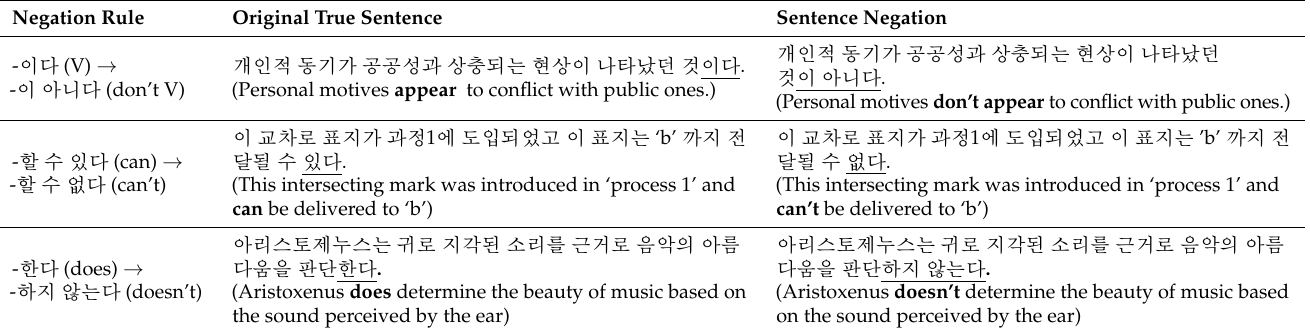
Figure 3. PLMs architecture. In this process, augmented sentences are split into positive and negative sentences using negation rules before being fed into the model. Finally, the prediction value is classified according to whether the answer is T or F . Table 3. Examples of sentences according to the negation rules. There are three negative expressions, Verb (V) → don’t V, can → can’t, and does → doesn’t. The underlined words in Korean indicate bold words in